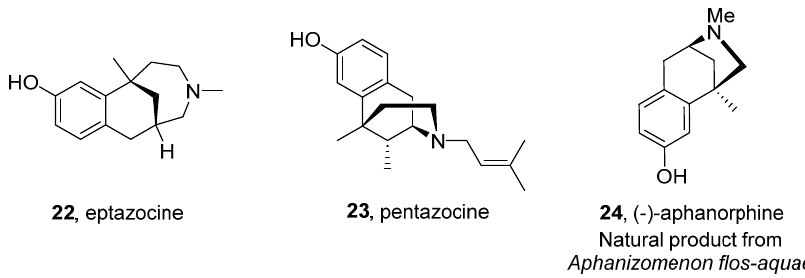
Figure 3. Representative examples of bioactive 3-benzazepines.